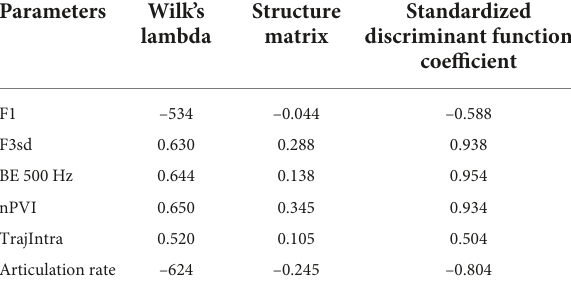
TABLE 5 Characteristics of the discriminant function for heart